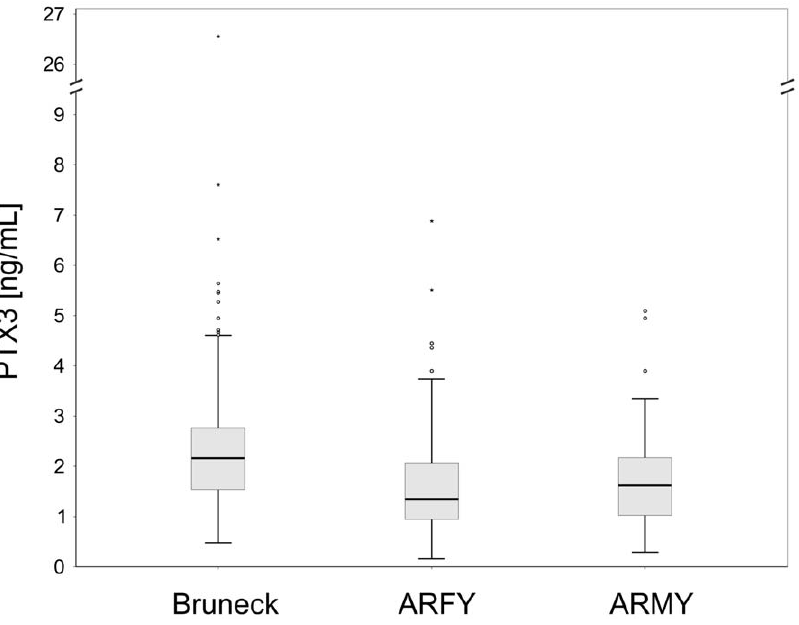
Figure 1. Distribution of PTX3 levels in the Bruneck (black), ARMY (blue) and ARFY (pink) study.